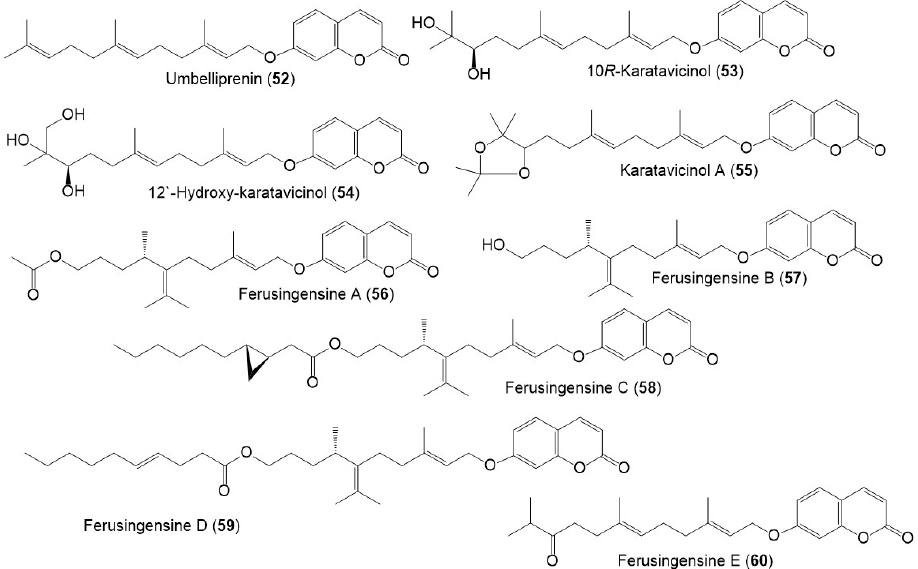
Figure 8. Structures of sesquiterpene coumarins ( 52 – 60 ) reported from F. sinkiangensis